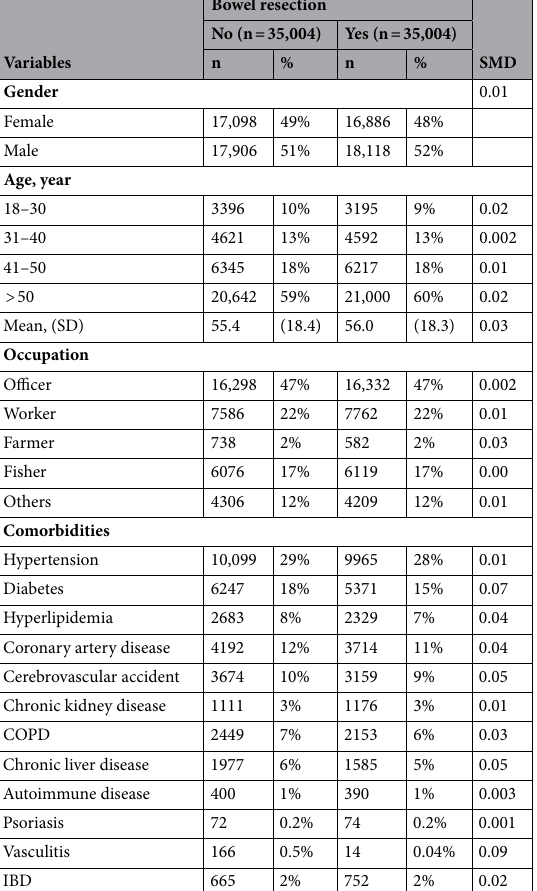
Table 5. Demographic Characteristics of Patients with and without Bowel Resection (Excluding Peptic Ulcer Disease Patients). SD standard deviation, SMD standardized mean difference, COPD chronic obstructive pulmonary disease, IBD inflammatory bowel